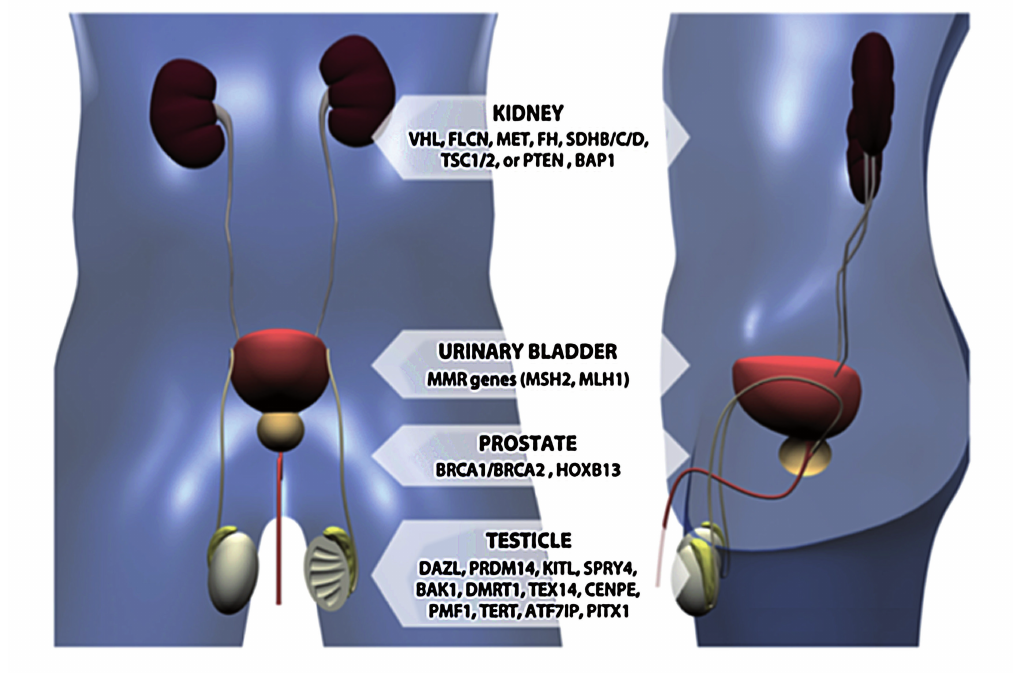
Figure 1 - Main genes related to urological malignances linked to genetic